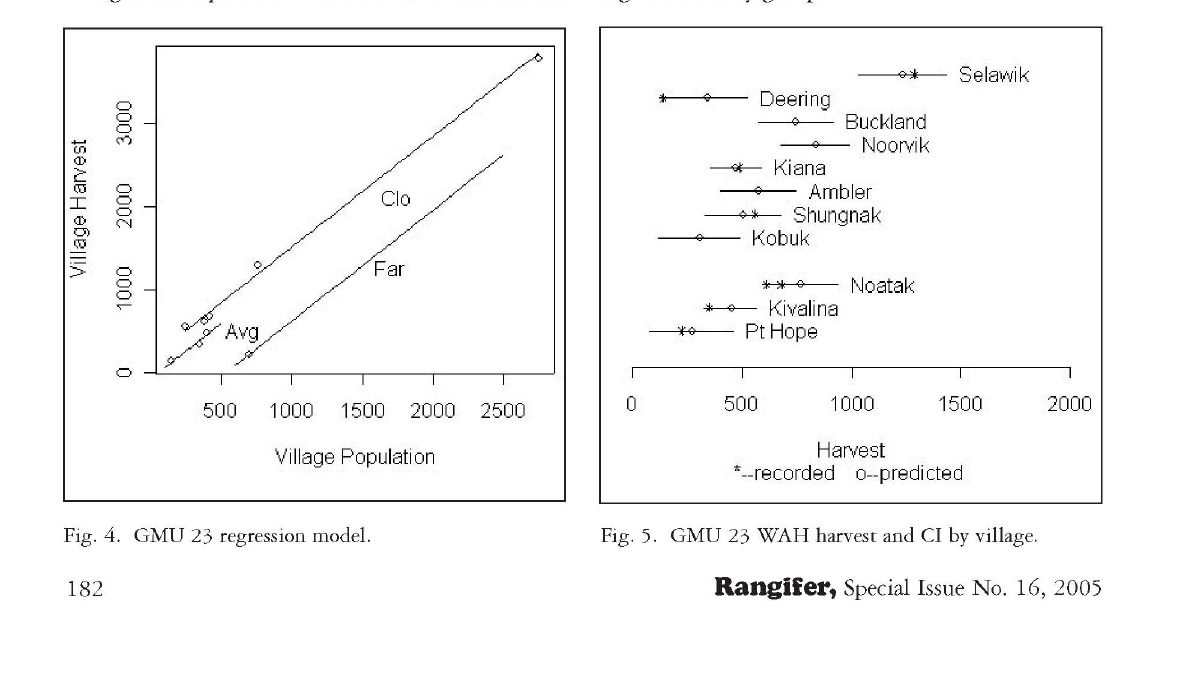
Fig. 4. GMU 23 regression model. Fig. 5. GMU 23 WAH harvest and CI by